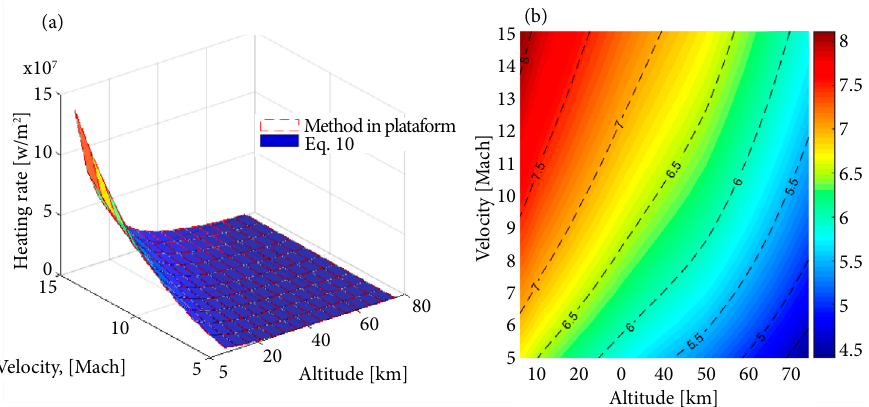
Figure 9. Heating rate of nose along the flight corridor of PRAHV.